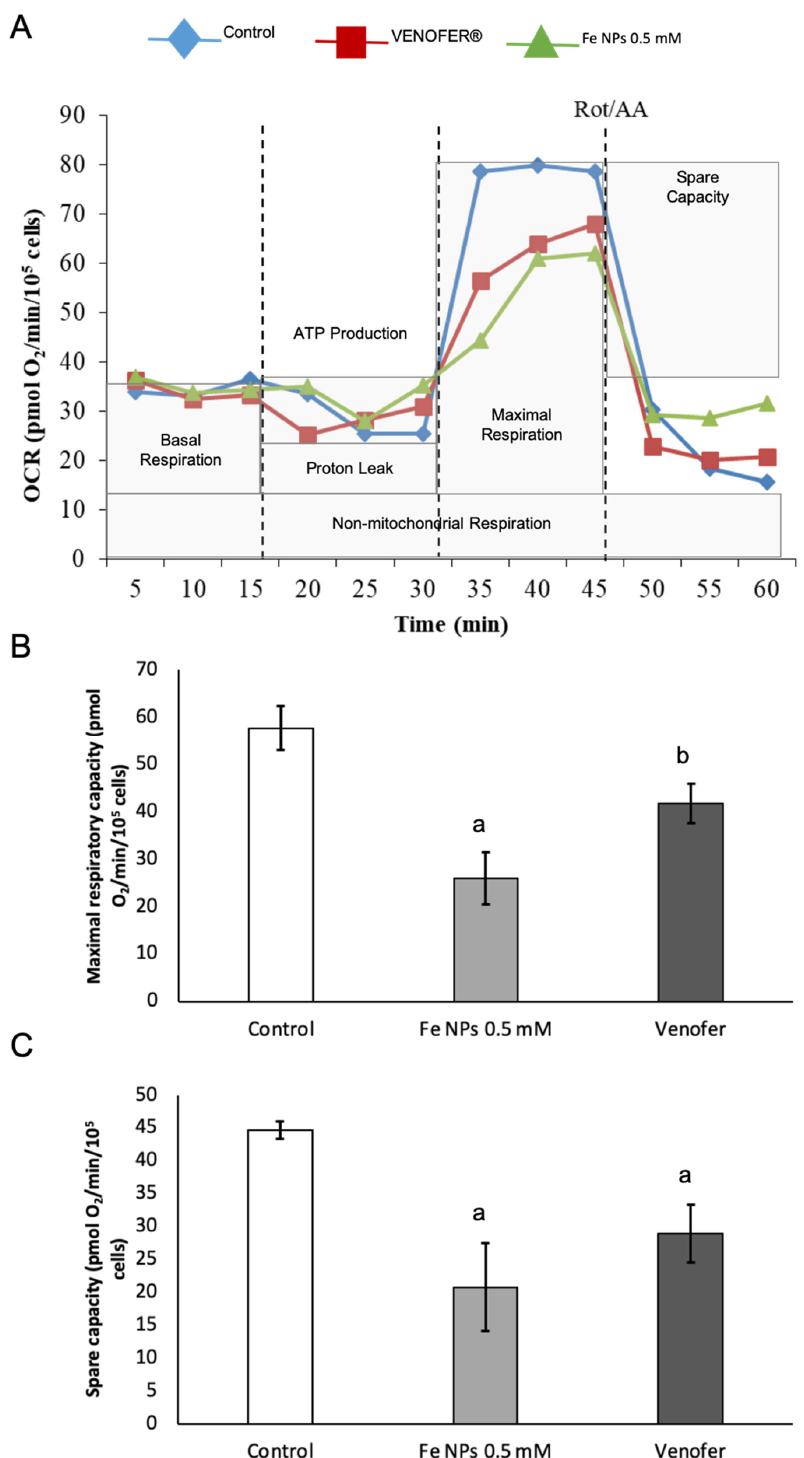
Figure 4. Modulation of mitochondrial respiration by iron nanoparticles in HT-29 cells. Cells were treated with DMEM (ctrl), iron nanoparticles Fe NPs or Venofer ® for 24 h. OCR was determined by using the Seahorse XF-24 Extracellular Flux Analyzer after the sequential injections of oligomycin (1 µg mL − 1 ), 2,4-DNP (1 mmol L − 1 ), and rotenone/antimycin (1 µmol L − 1 /10 µmol L − 1 ). ( A ) shows OCR. ( B ) shows maximal respiratory capacity. ( C ) shows the spare capacity. Data are indicated as the mean ± SEM ( n = 3). (a) vs. control; (b) vs. Fe NPs 0.5 mM ( p < 0.05).